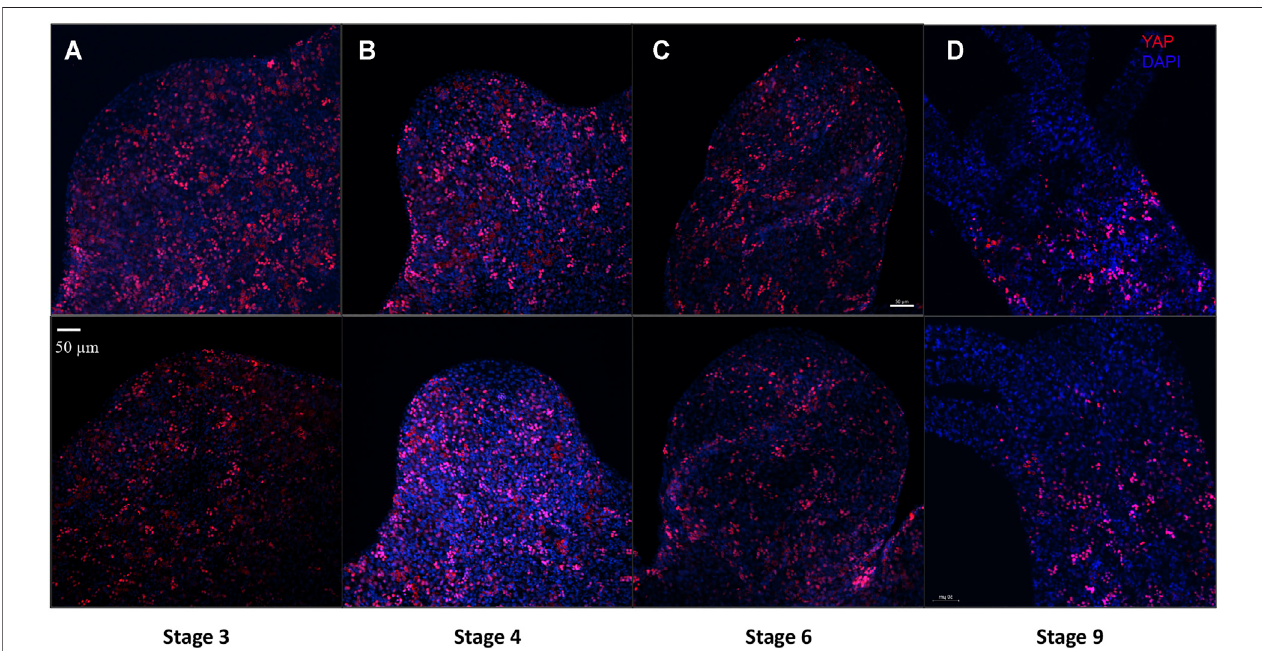
FIGURE 7 | YAP positive cells are recruited early to the bud tip and are excluded from the region which are terminally differentiated in the late stages of bud development.Immuno fl uorescenceassayof Hvul _YAPperformedusinganti-CheYkiantibodyfordifferentbuddingstages(representedbytwopolypsfordepictingeach stage) of Hydra showing recruitment of YAP positive cells to the budding tip. (A) Stage 3 shows early recruitment of YAP positive cells to the emerging bud with non- clustered cells at the distal tip with slight depletion at tip of the bud. (B) at Stage 4, depletion of the YAP expressing is more prominent which gets further exaggerated at (C) Stage 6 and (D) Stage 9. Red: YAP & Blue: DAPI (Scale bar, 50 μ m, N (cid:2) 3 per